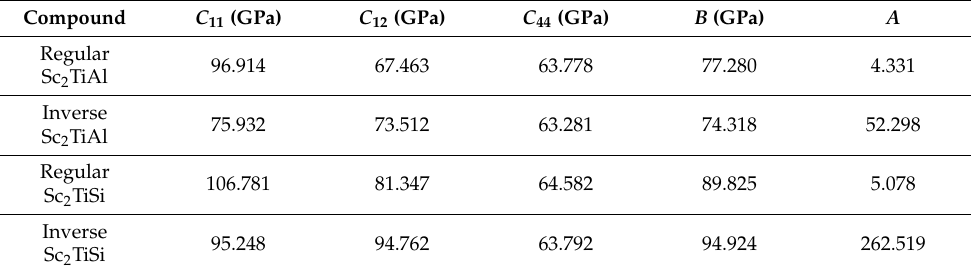
Table 3. Elastic constants ( C ii ) , bulk modulus ( B ), and anisotropic factor ( A ) of Sc 2 TiAl and Sc 2